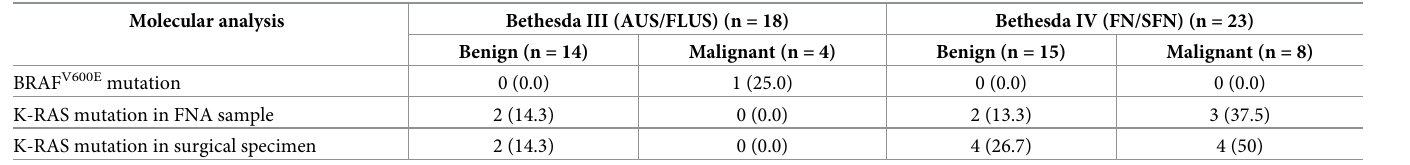
Table 3. Molecular analysis based on Bethesda category.